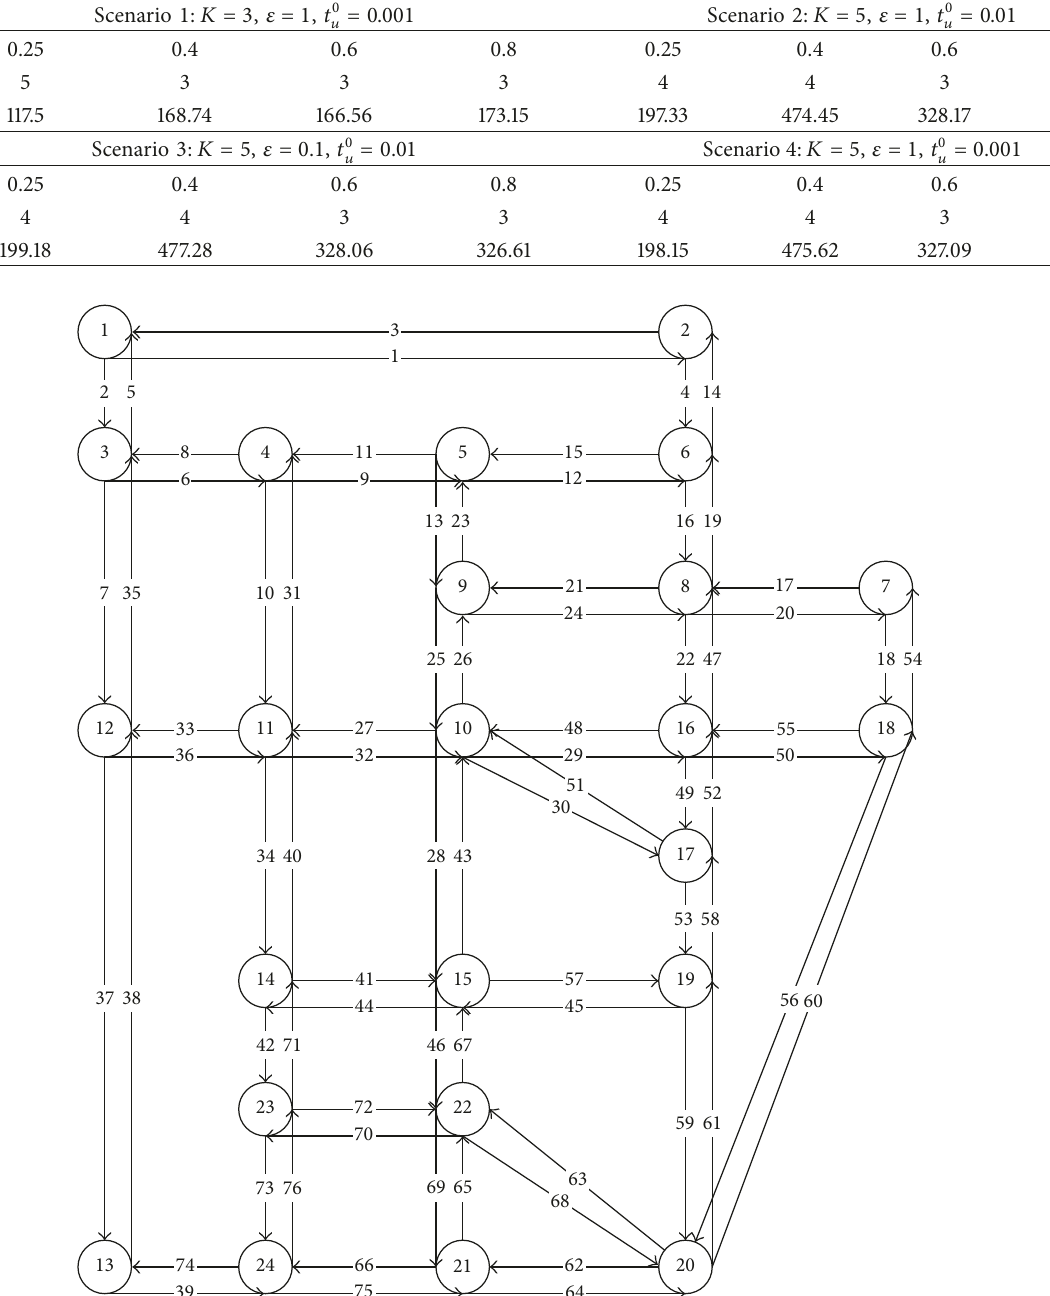
Figure 5: Sioux Falls network with 24 nodes and 76